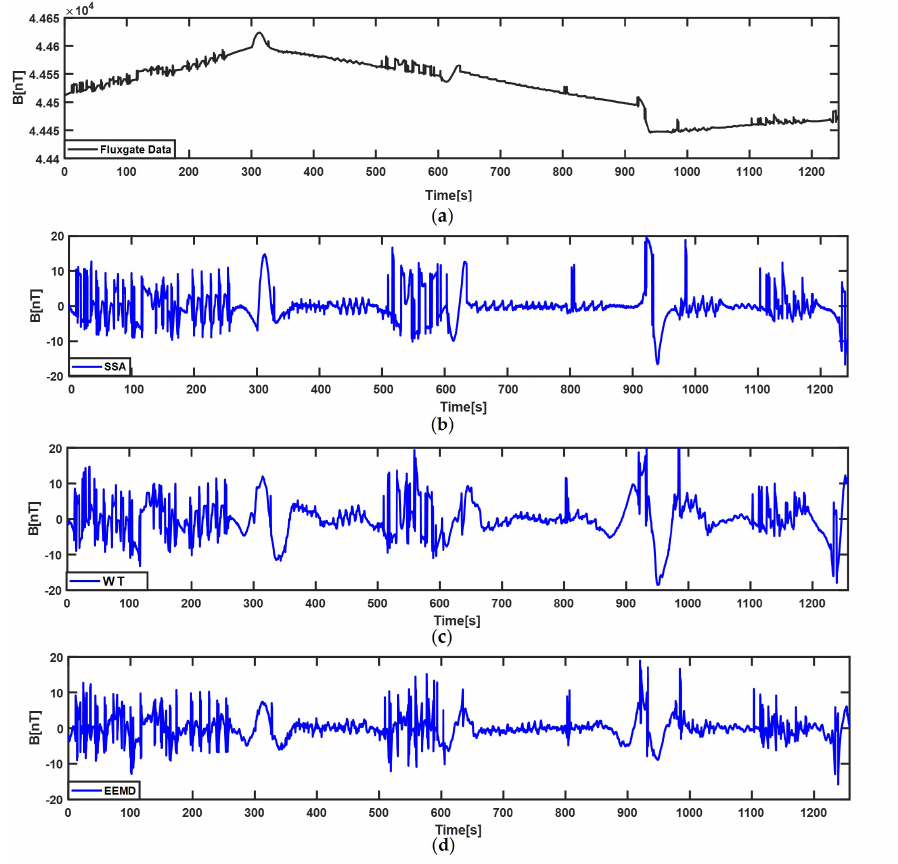
Figure 4. The extraction results of three methods for ECMI of the first–lap. ( a ) the compensated STMF of the fluxgate vector magnetometer; ( b ) the characteristic signal of ECMI extracted by SSA; ( c ) the characteristic signal of ECMI extracted by WT; ( d ) the characteristic signal of ECMI extracted by